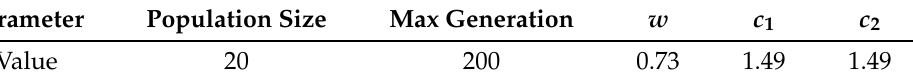
Table 2. PSO parameter values.